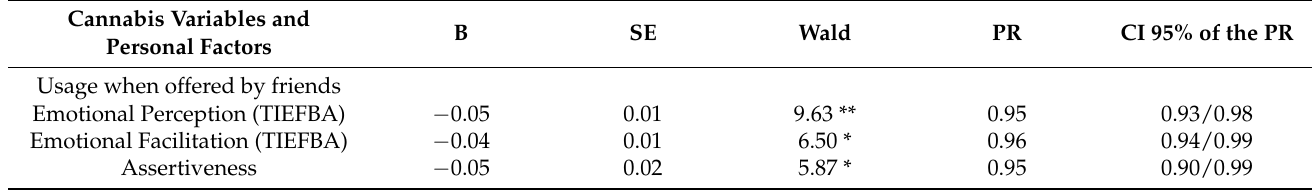
Table 6. Binomial regression analysis based on the 12–13 years age group.